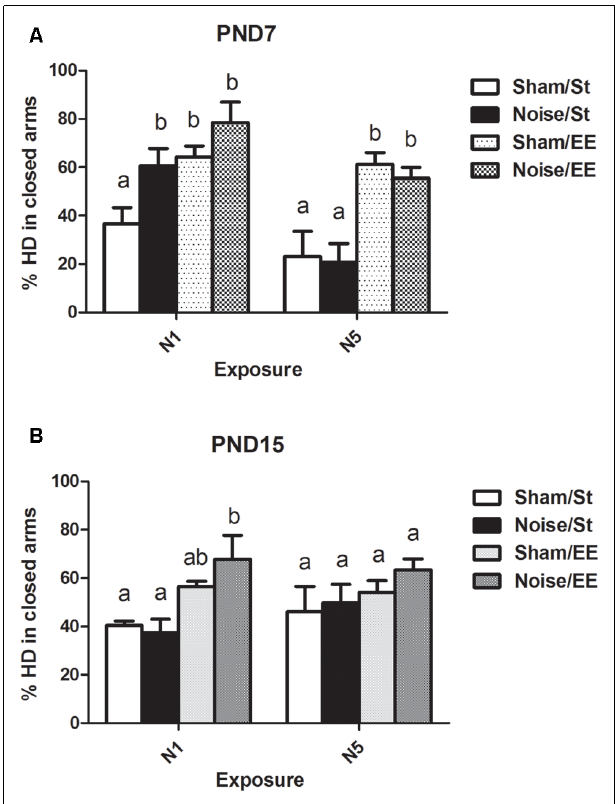
FIGURE 7 | Percentage of head dipping (HD) in closed arms in the EPM task made by PND28 animals exposed to noise at PND7 and PND15. (A) PND28 animals exposed at PND7; (B) PND28 animals exposed at PND15. Sham: non- exposed animals; N1: single noise exposure; N5: five-daily noise exposure. St: standard housing. EE: enriched environment. Different letters (a, b) symbolize significant differences with p < 0.05. Data represent the mean ± SEM of the % of HD in closed arms made in the EPM task, n = 7 for each